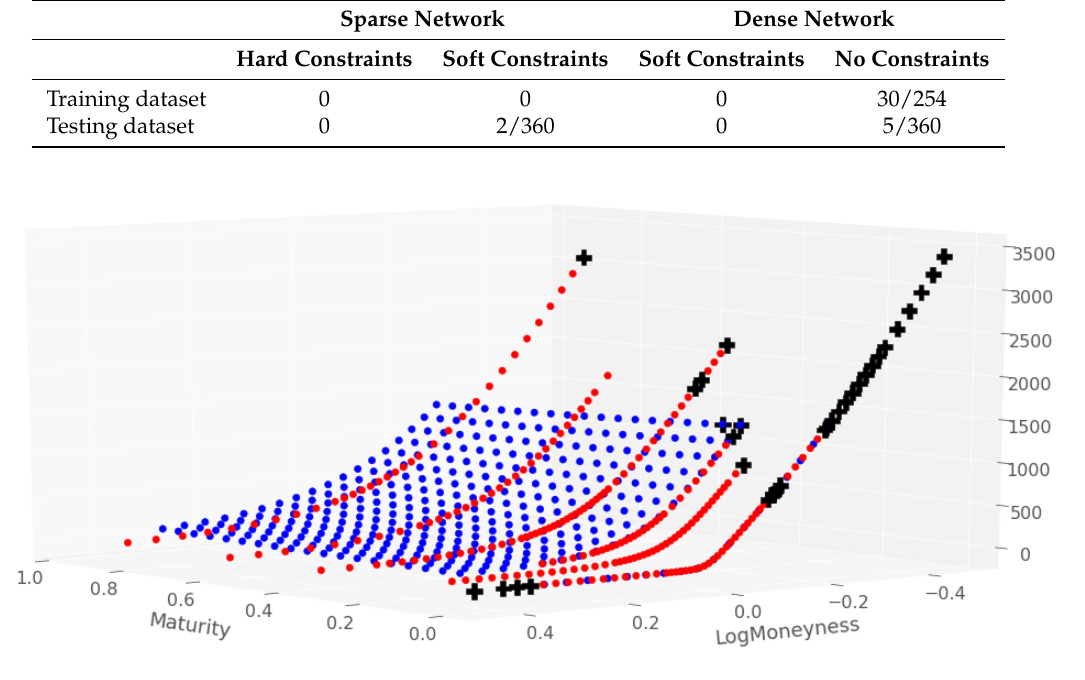
Figure 6. Location of the violations, denoted by black crosses, corresponding to the right column in Table